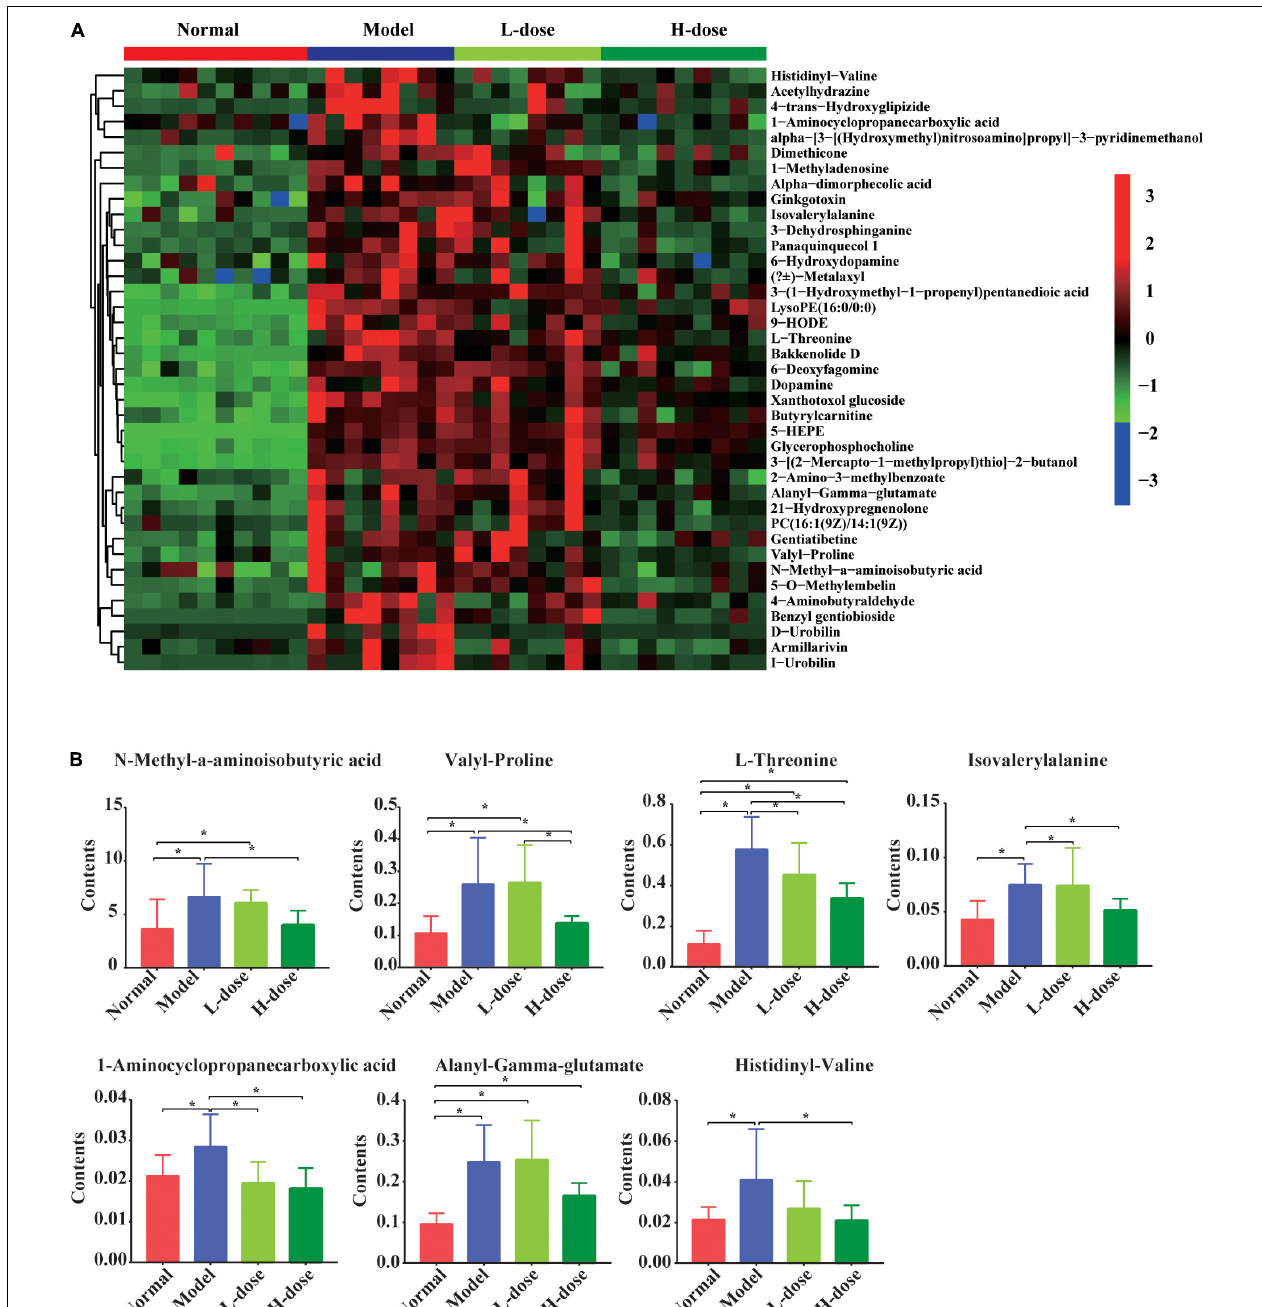
FIGURE 3 | The influenced gut metabolites after Lactobacillus and Bifidobacterium probiotics supplements in GDM rats. (A) Hierarchical clustering analysis of 44 metabolites in GDM rats and GDM rats treated with Lactobacillus and Bifidobacterium probiotics supplements. (B) The comparison of seven amino acids by the ANOVA/Kruskal–Wallis and post-hoc test. * P <